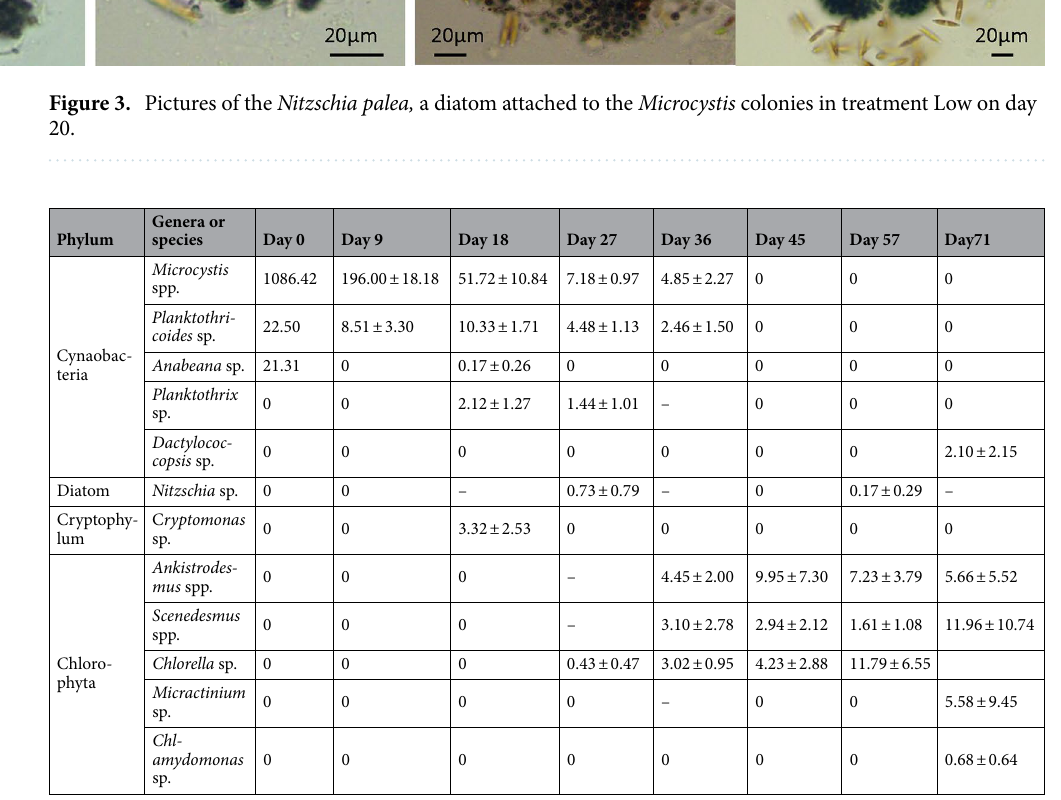
Table 4. Algal changes in the five dominant genera in treatment Medium (wet weight, mg L −1